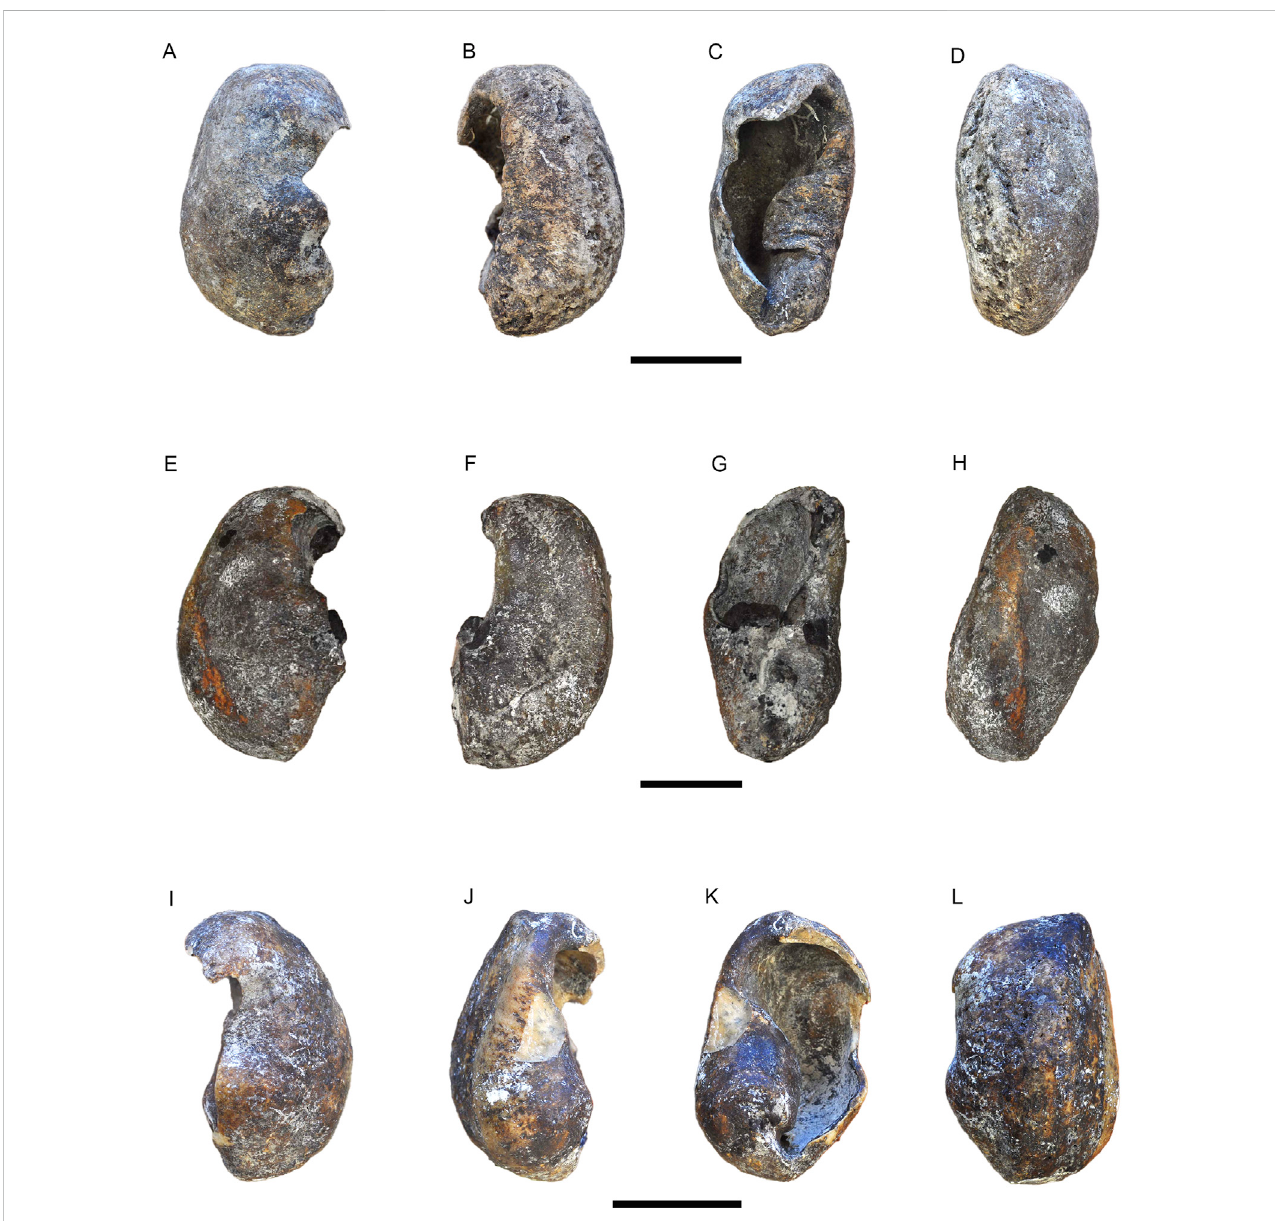
FIGURE 7 Balaenopteridae indet., SAM-PQ-3083 in (A) ventral, (B) dorsal, (C) lateral, and (D) medial view, scale=5 cm. SAM-PQ-3089 in (E) ventral, (F) dorsal, (G) lateral, and (H) medial view, scale=5 cm. SAM-PQ-3085 in (I) ventral, (J) dorsal, (K) lateral, and (L) medial view, scale=5 cm.